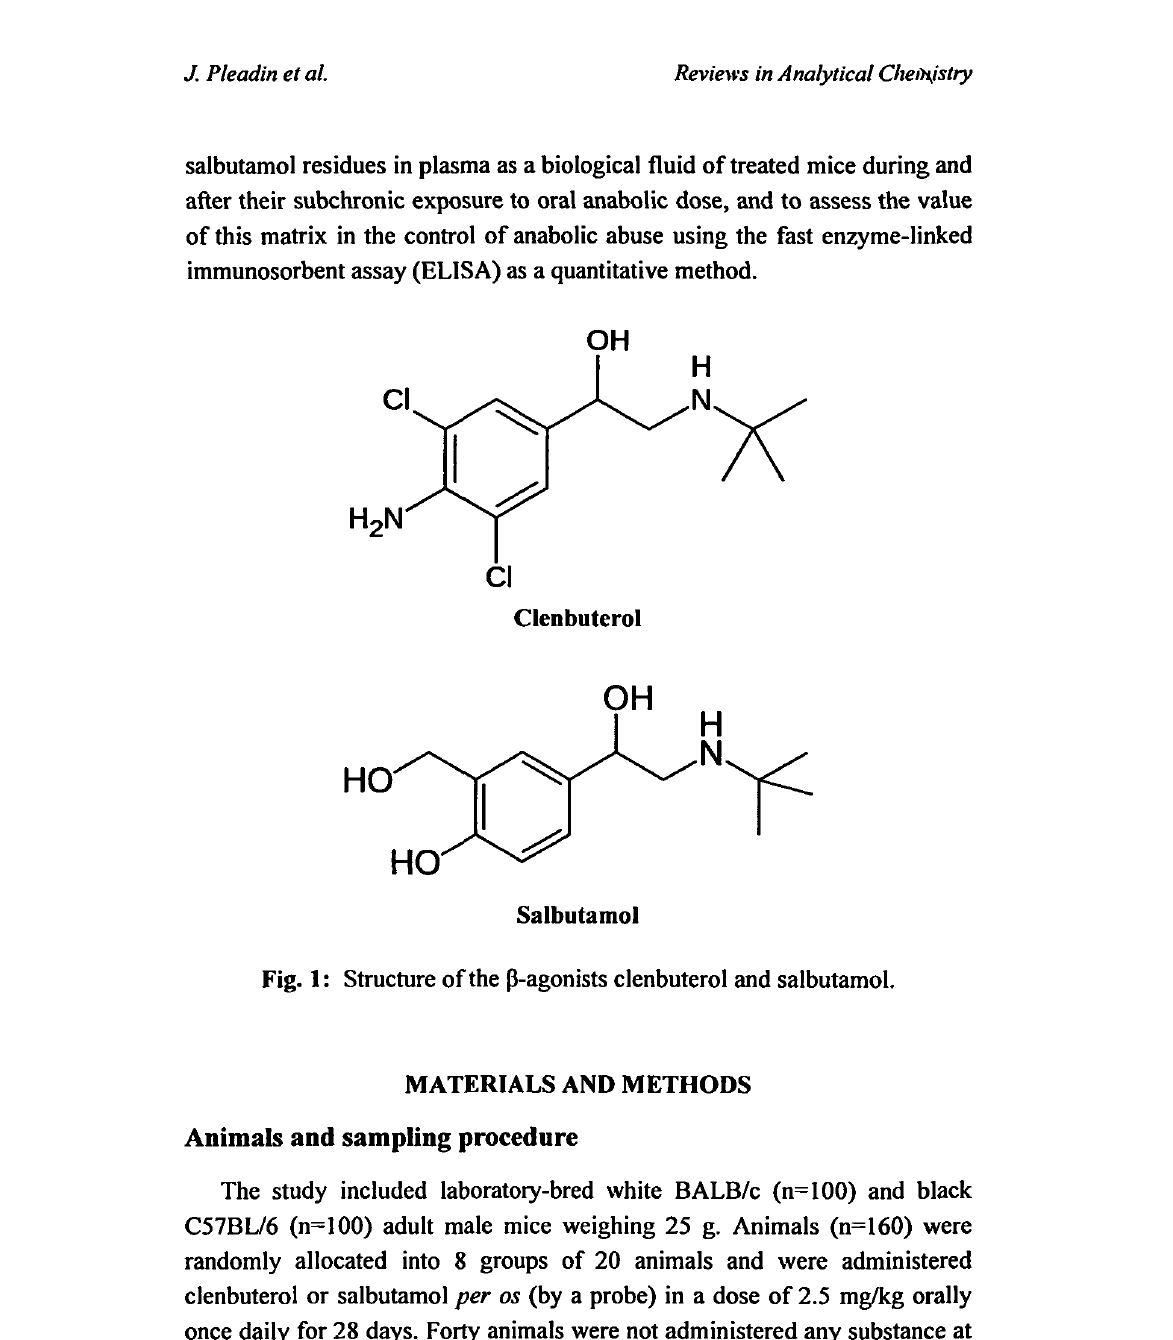
Fig. 1: Structure of the ß-agonists clenbuterol and